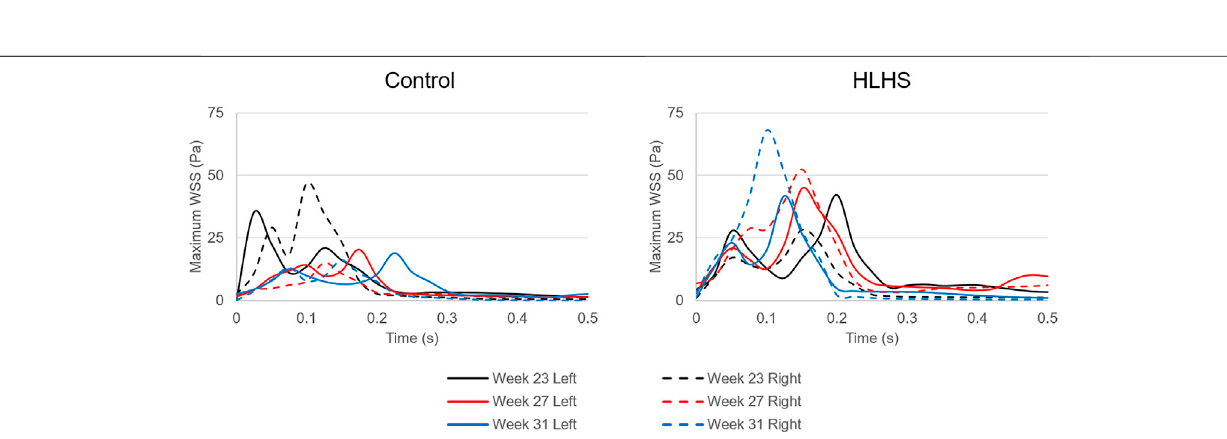
Frontiers in Physiology |